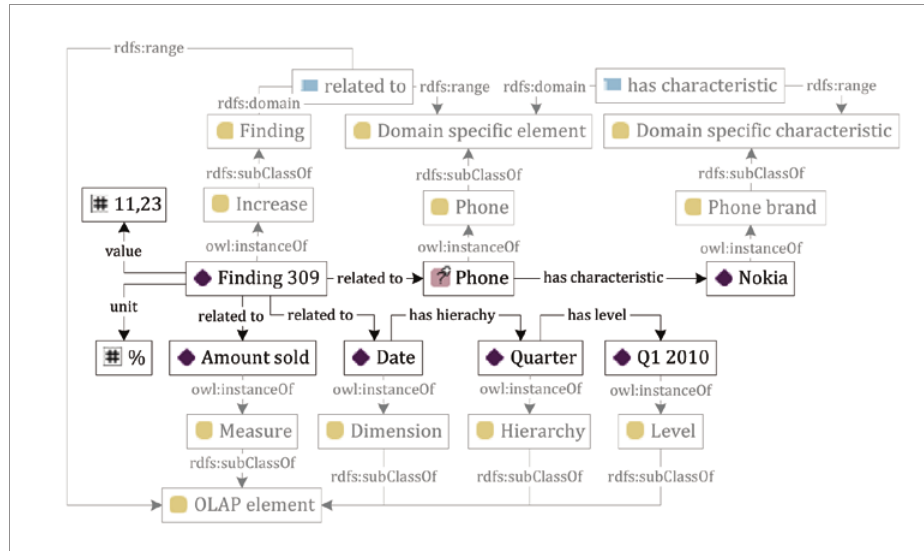
Fig. 9. Example of representing the finding in ontology